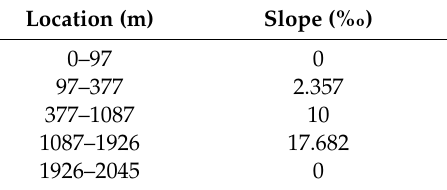
Table 4. Ramp data.